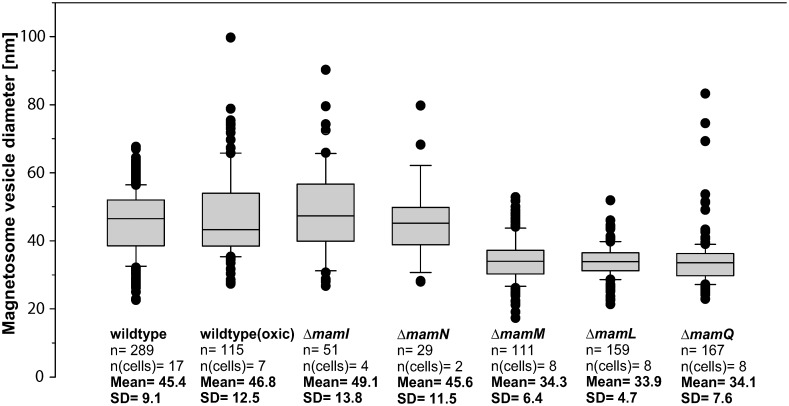
Diameters of magnetosome membranes and similar structures from wild type and several mutant strains.Diameters of magnetosome membranes (MMs) or dense MM-like structures were measured from cryo-electron tomograms. Box plots are indicating 10th and 90th percentiles (whiskers), 25th and 75th percentiles (box), median and outliers. The number of measured membranes [n] and analyzed cells [n(cells)] are indicated. The mean value and the standard deviation (SD) of the diameters are given for each strain.